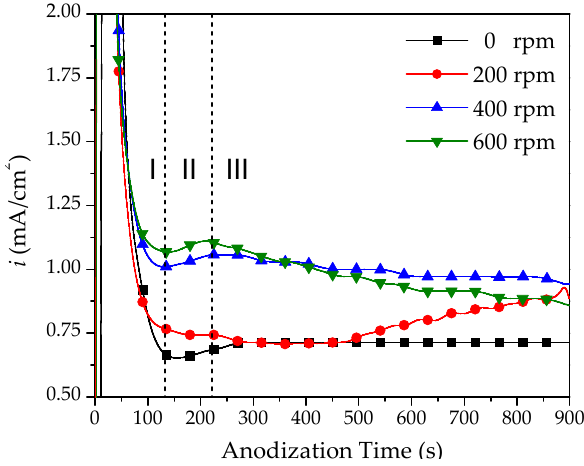
Figure 1. Current density–time responses for anodizing on 304L SS for 15 min in ethylene glycol- NH 4 F-H 2 O electrolyte at different stirring